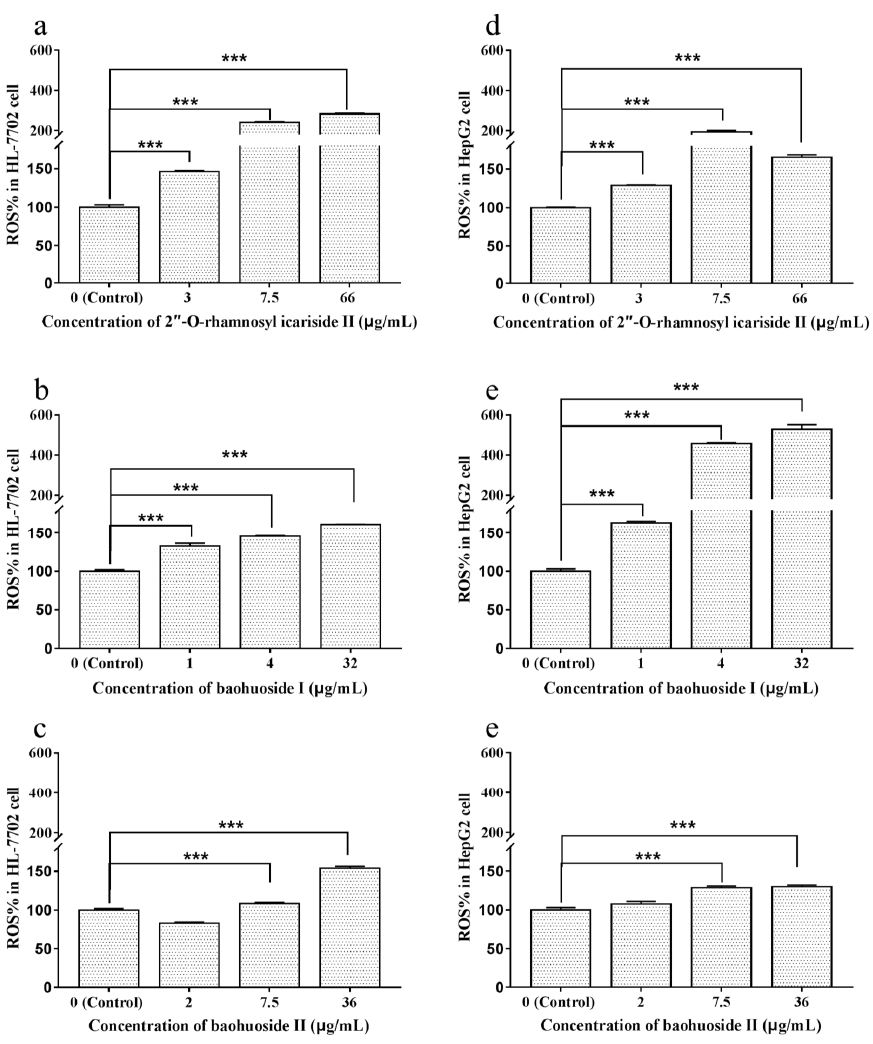
Figure 4. Effects of 2 ″ - O -rhamnosyl icariside II, baohuoside I and baohuoside II on the ROS level in HL-7702 and HepG2 cells at 24 h. Notes: Except baohuoside II at low concentration, the other groups caused significant increases ( p < 0.005) in HL-7702 ( a – c ) and HepG2 ( d – f ) cells. Each value is the mean ± SD of three experiments. * p < 0.05, ** p < 0.01, and *** p < 0.005 compared with the control group ( ROS = reactive oxygen species).